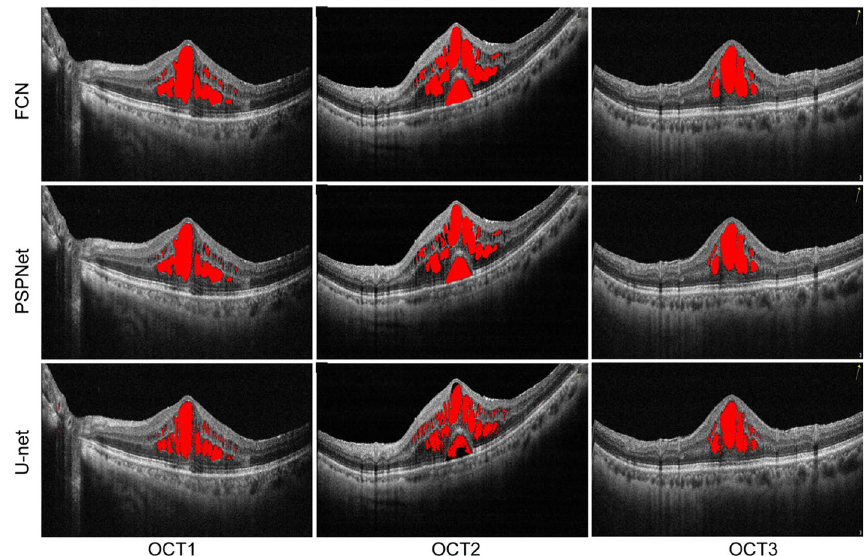
Figure 9. Segmentation results of macular edema by different methods.